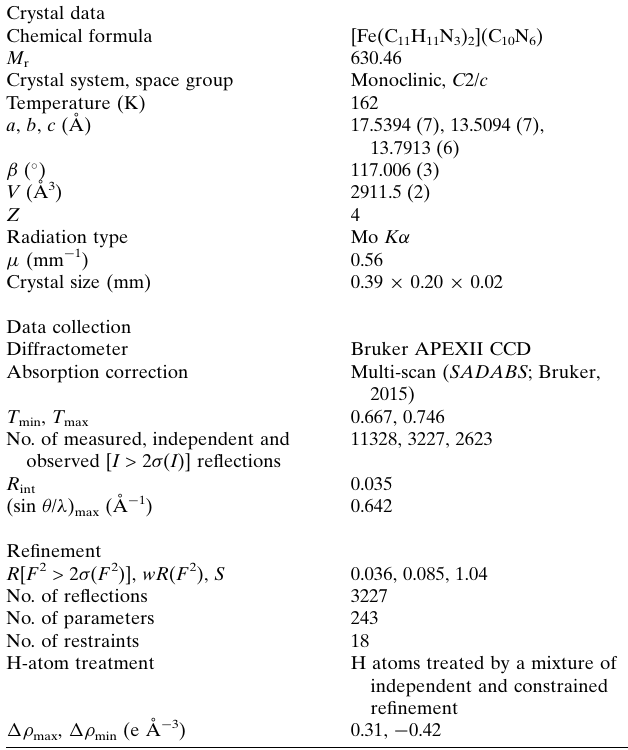
Crystal data Chemical